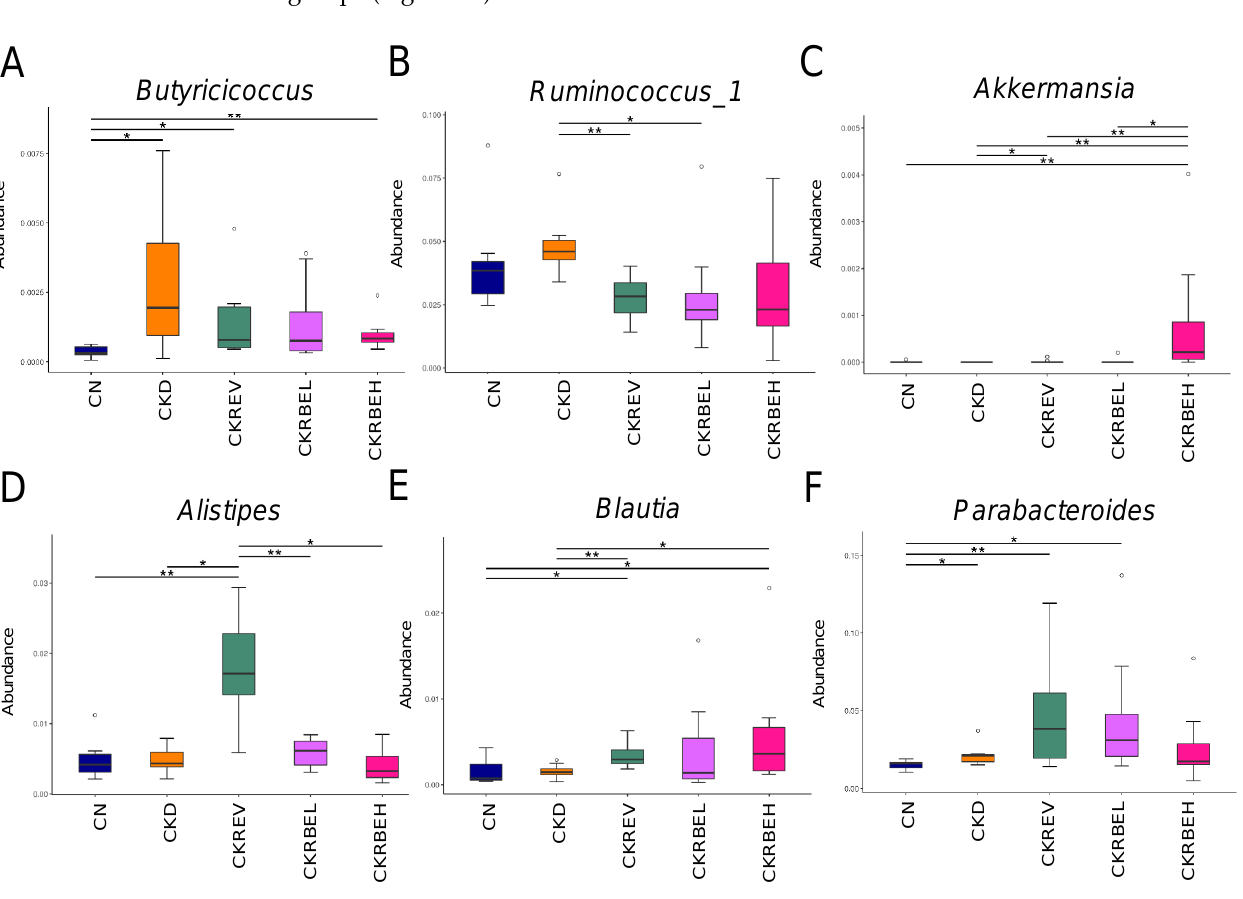
Figure 6. Effect of adenine-induced chronic kidney disease (CKD), resveratrol, or resveratrol butyrate ester on the gut microbiome. Relative abundance of the genera ( A ) Butyricicoccus , ( B ) Ruminococcus_1 , ( C ) Akkermansia , ( D ) Alistipes , ( E ) Blautia , and ( F ) Parabacteroides . N = 8/group. * p < 0.05; ** p <